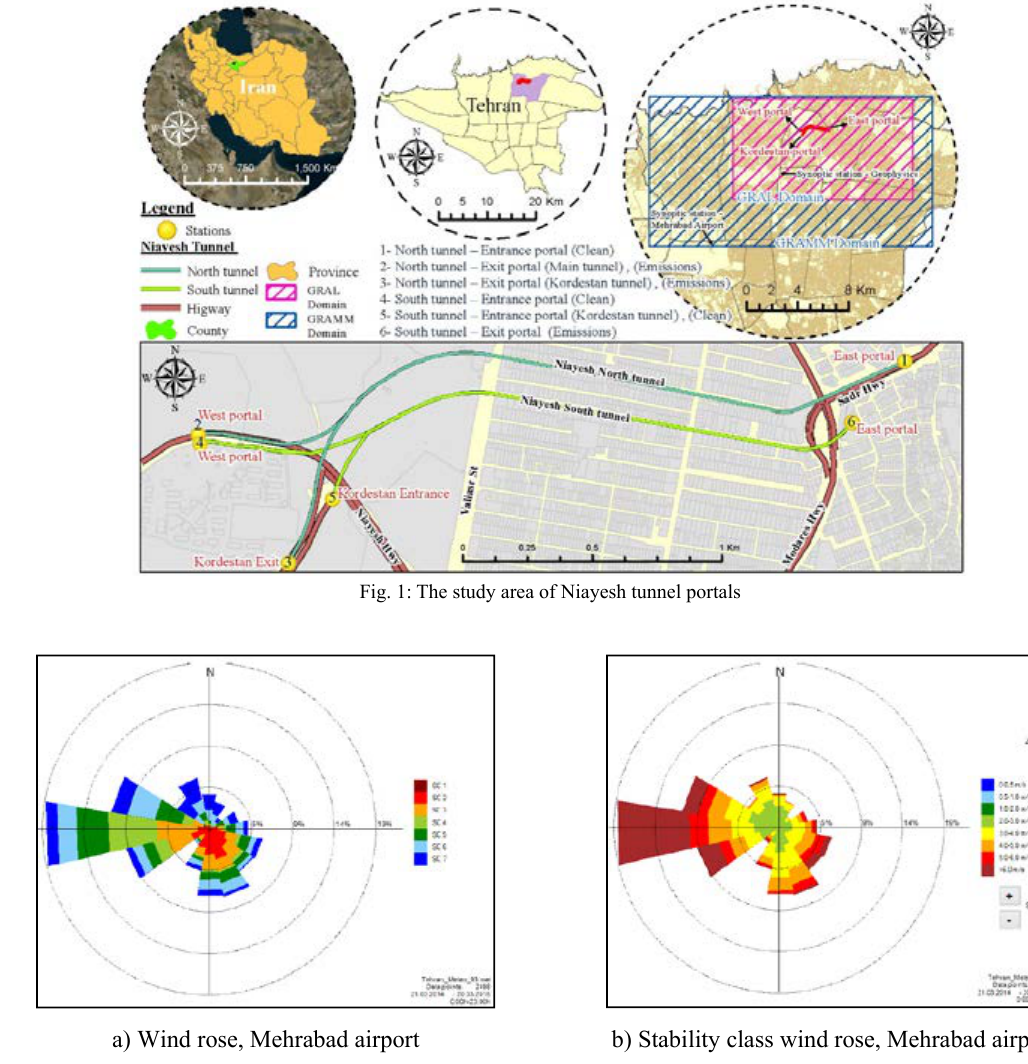
Fig. 2: Stability class wind rose (a), wind rose, Mehrabad Airport (b)